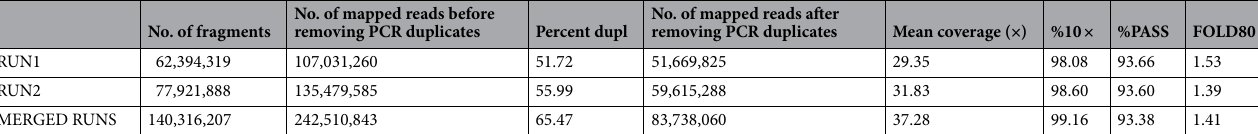
Table 2. Performance of the two WES runs. The table shows the number of sequenced fragments, the number of mapped reads before and after duplicate removal, the percentage of duplicated reads, the average coverage of the target, the percentage of the target covered at least by 10 reads, the genotypability, and the uniformity of coverage (FOLD80 penalty value).